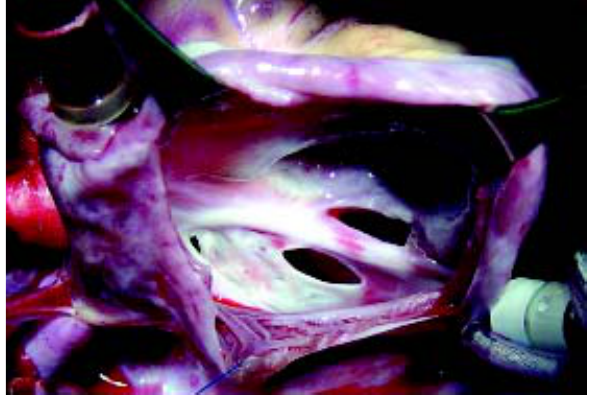
Fig. 1 – Atriotomia direita onde se observa três orifícios. Dois na lâmina da fossa oval (comunicação interatrial tipo ostium secundum). Outro próximo à valva atrioventricular direita correspondente ao seio coronário sem